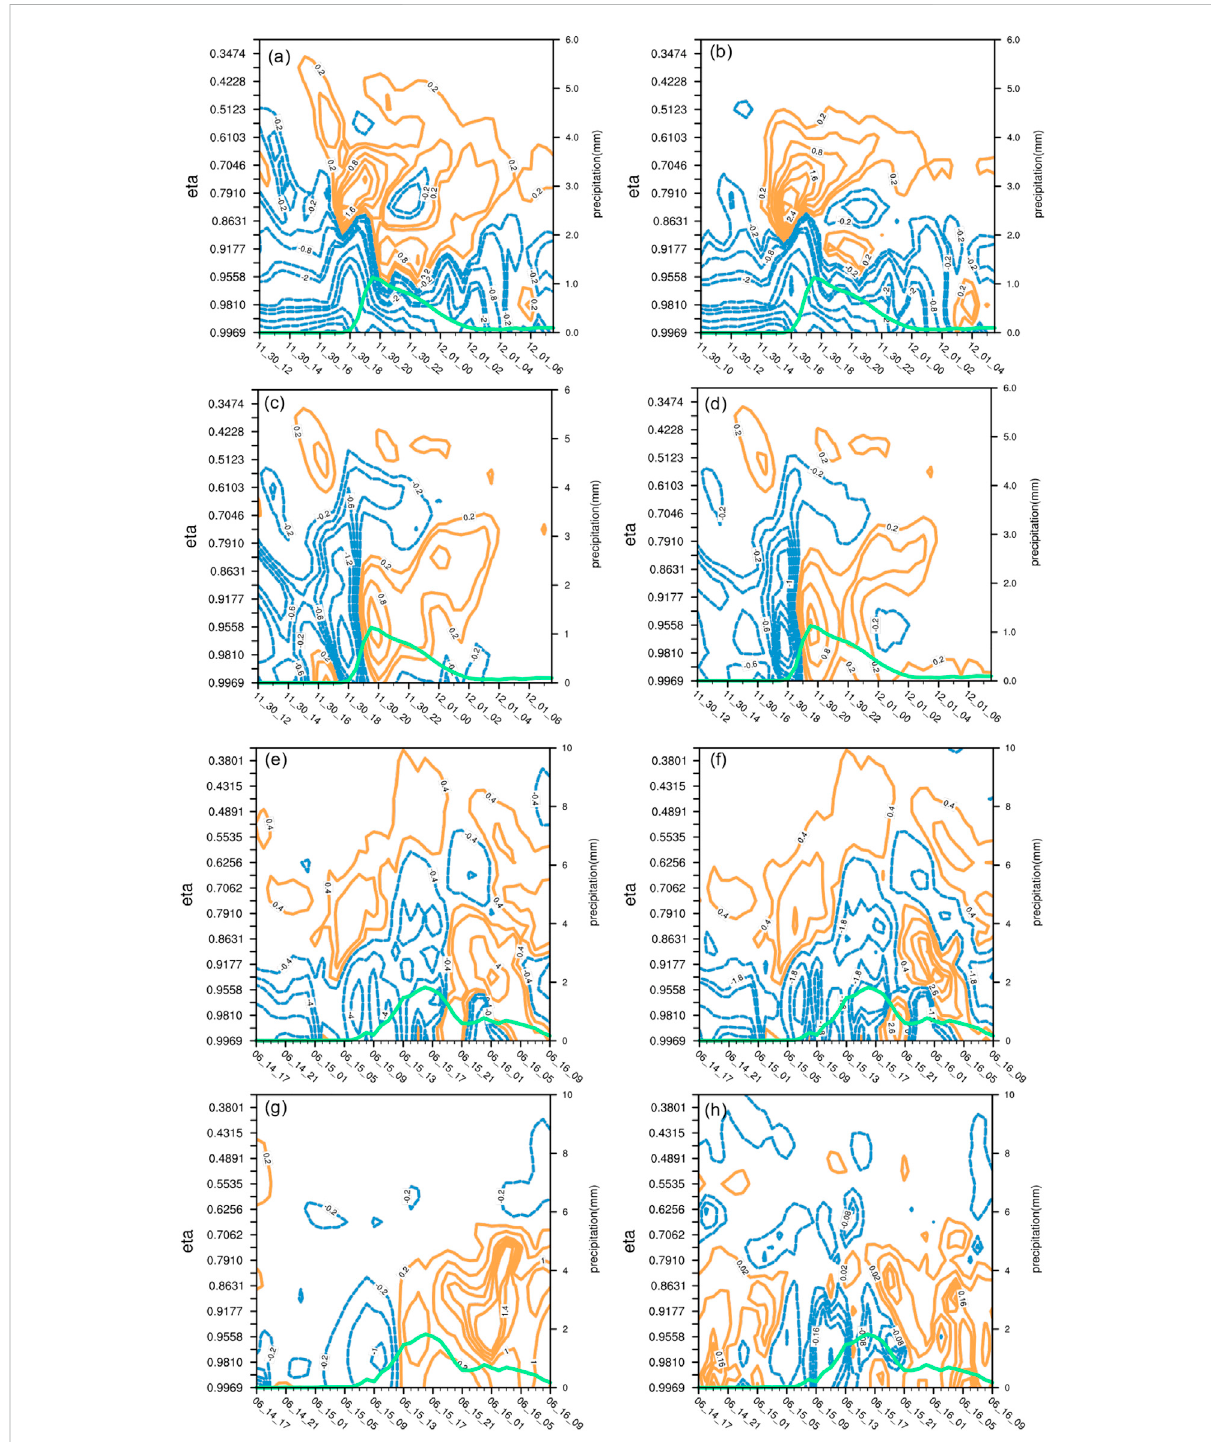
FIGURE 3 Domain averaged (A) Q all , (B) Q div , (C) Q B S and (D) Q H S in the unit of 10 − 7 g cm − 2 hPa − 1 s − 1 in the winter case from 1200UTC 30 November to 0730UTC1DecemberwiththetargetdomainmarkedbyabluerectangularregioninFigure1F. (E – H) arethesameexceptforthesummercasefrom 1700UTC 14 to 0900UTC 16 June with the target domain marked by a red rectangular region in Figure 1H. The green curves represent the 30-min accumulated precipitation (right y-axis, units: